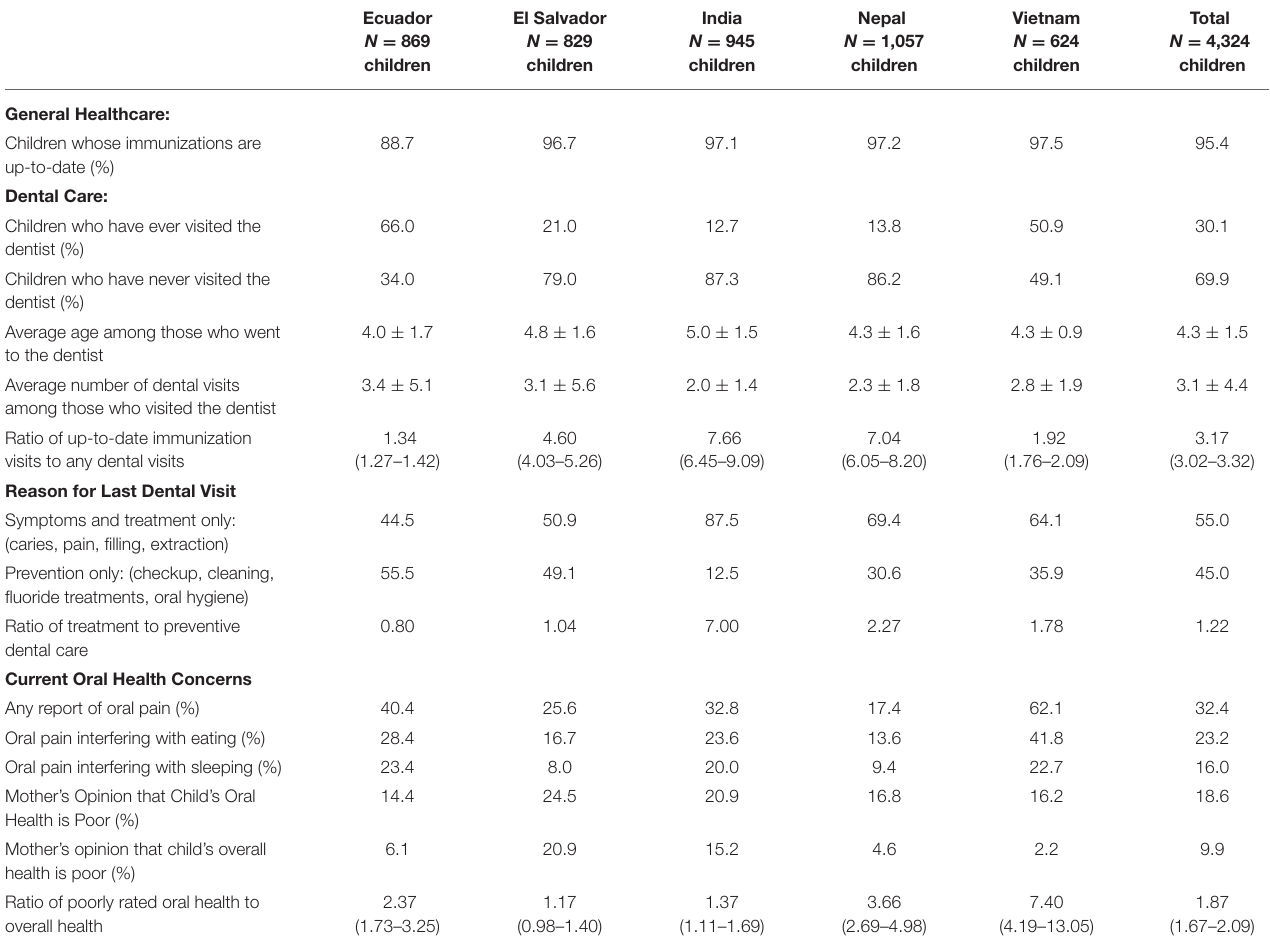
TABLE 3 | Children’s utilization of general healthcare and dental